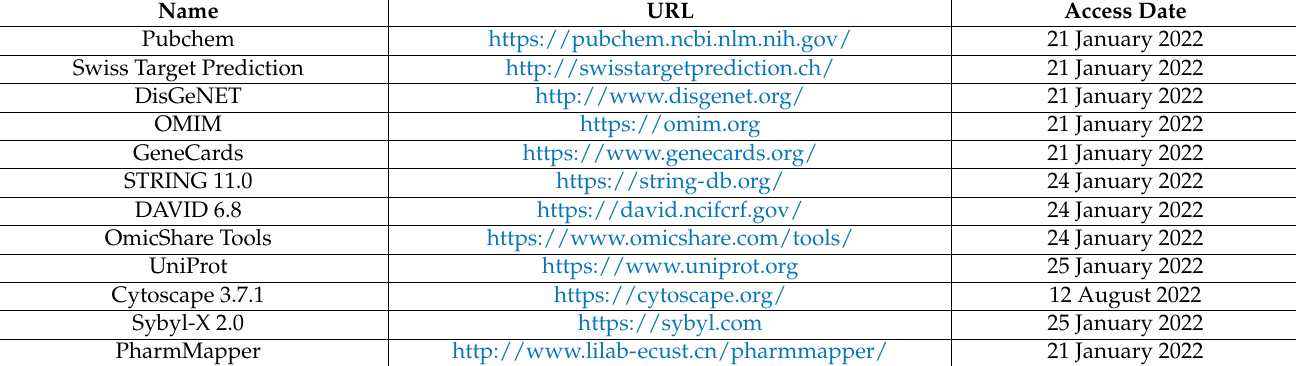
Table 1. The experimental databases and software used in the network pharmacology approach.